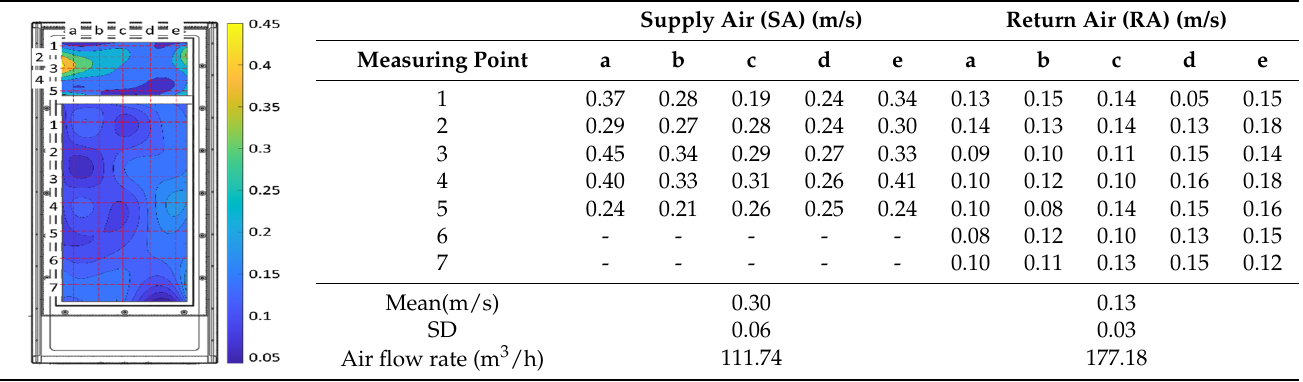
Table 4. Surface wind speed and total air volume of the vegetation biofilter mockup, measured based on a test standard (SAREK A101-2017).